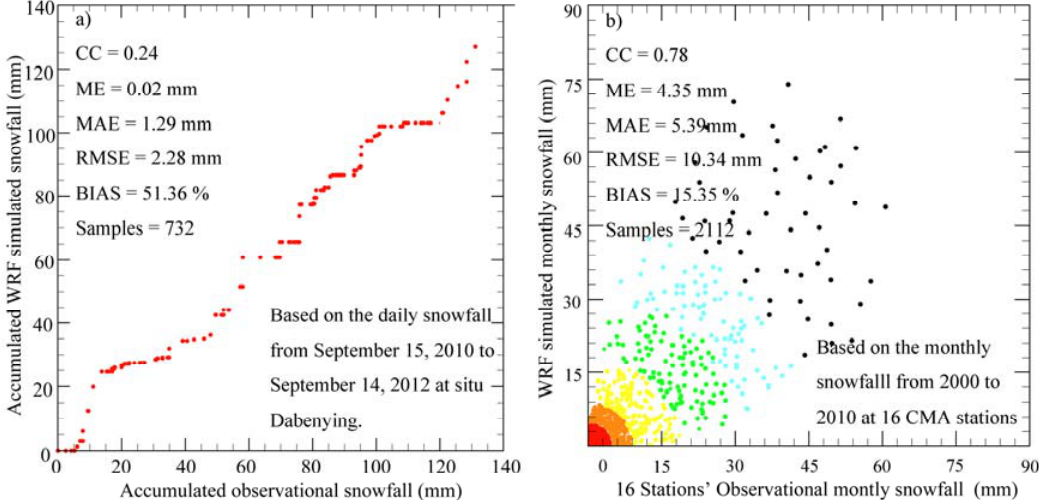
Figure 2. Comparison of daily snowfall between the weather research and forecast model (WRF) simulation and observational data ( a ) at the Dabenying site; ( b ) at CMA stations.